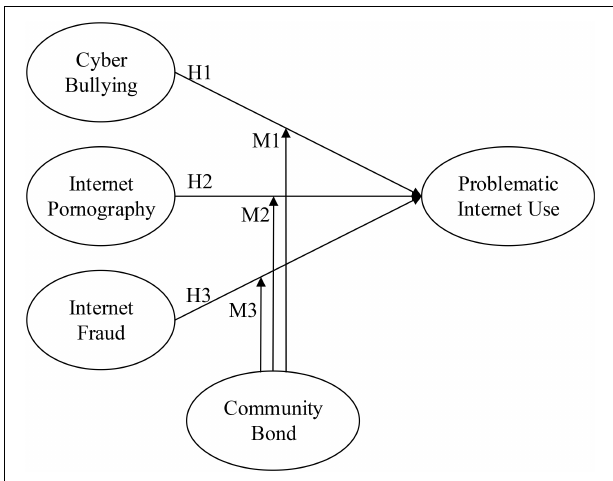
FIGURE 1 | Research